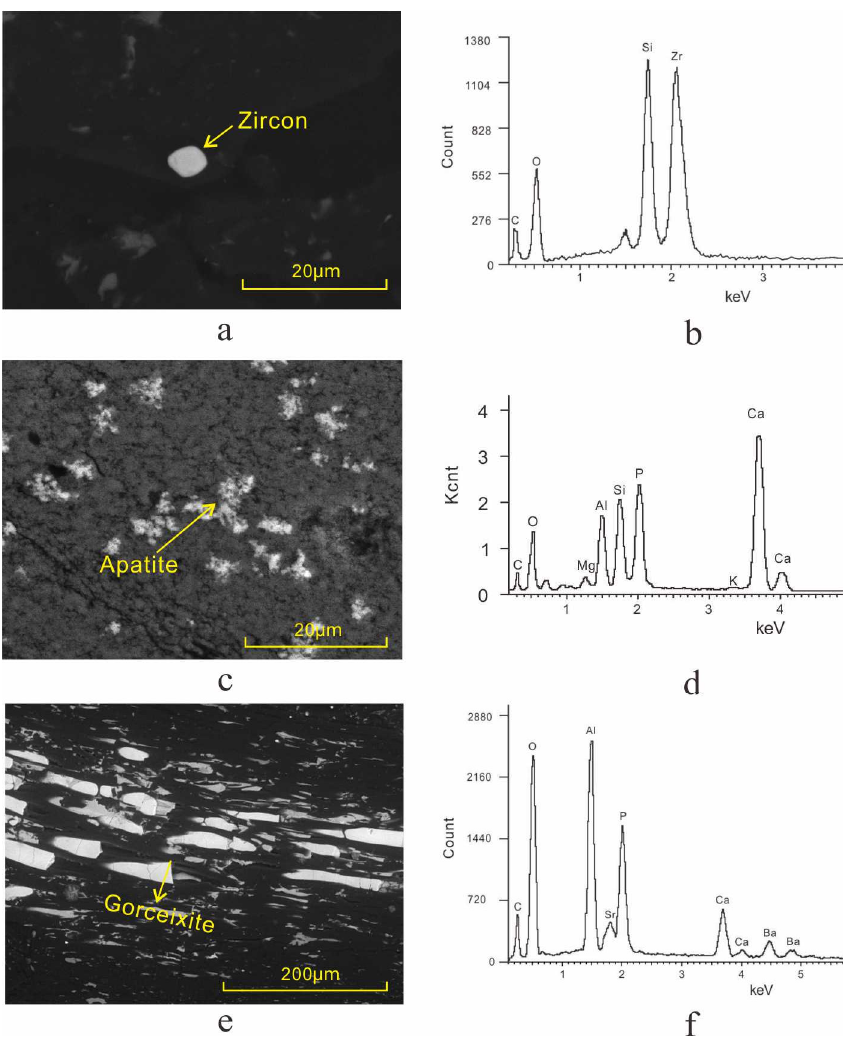
Figure 7. SEM back-scattered electron images and X-ray EDS spectrograms of minerals in the coals of Huainan coalfield. ( a ) Zircon occurring as a sub-round grain, S15, P1 mine, No. 8 coal seam; ( b ) X-ray EDS spectrum of zircon in ( a ); ( c ) apatite scattered over the kaolinite, S11, XZZ mine, No. 8 coal seam; ( d ) X-ray EDS spectrum of apatite in ( c ); ( e ) gorceixite occurring as cell infillings, S6, WFG mine, No. 13-1 coal seam; and ( f ) X-ray EDS spectrum of gorceixite in ( e ).